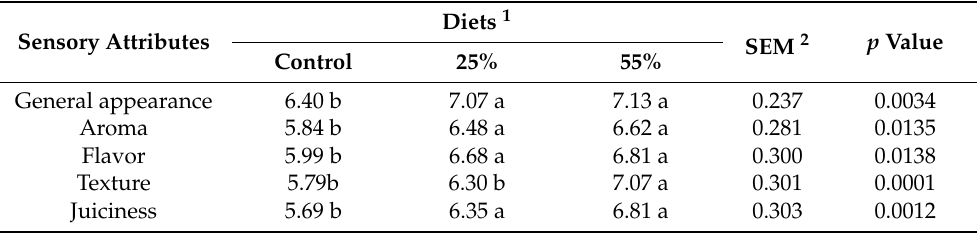
Table 6. Sensory analysis of the Longissimus lumborum muscle of goats fed forage cactus as a substitute for Tifton 85